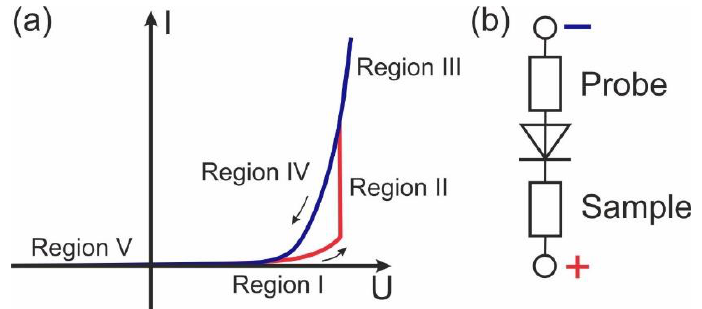
Figure 5. ( a ) Schematics of the hysteretic I-V dependencies with RS obtained in BFO films. Arrows indicate the counterclockwise (CC) direction of the bypass. ( b ) Lumped-based scheme of the probe, sample, and Schottky-barrier in the CAFM experiment.